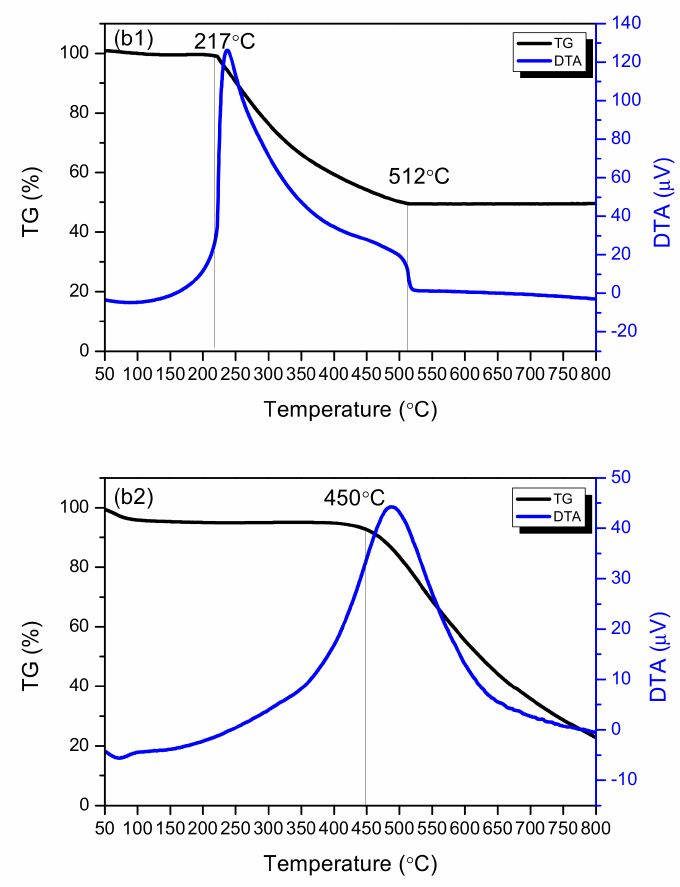
Figure 1. DTA patterns of ( b1 ): Co/AC, ( b2 ):